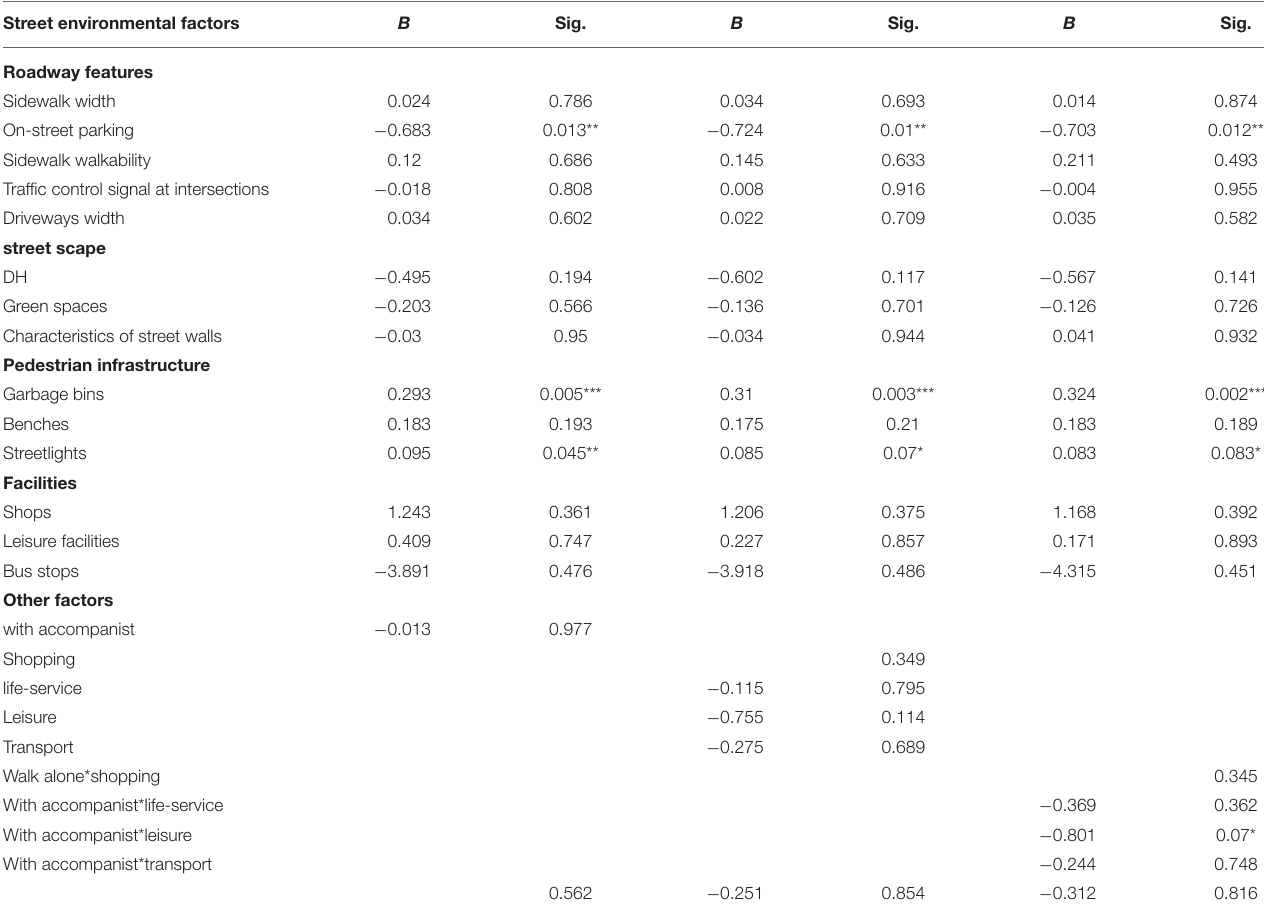
TABLE 7 | Other factors affecting non-selected shortest